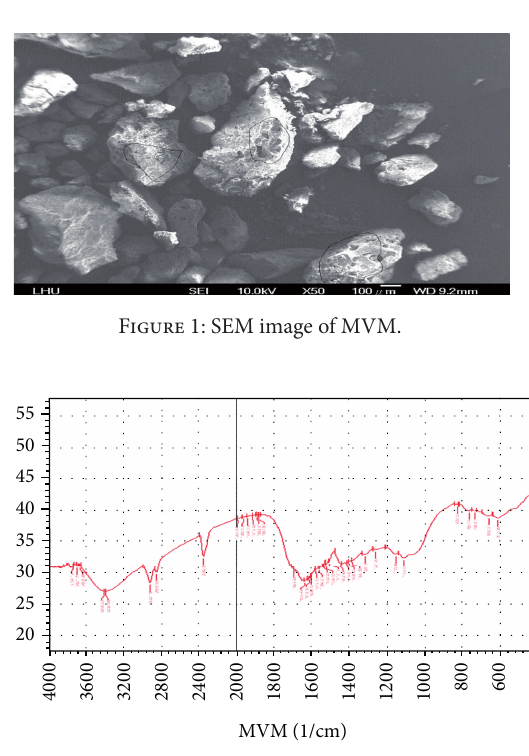
F 2: FTIR spectra of MVM.